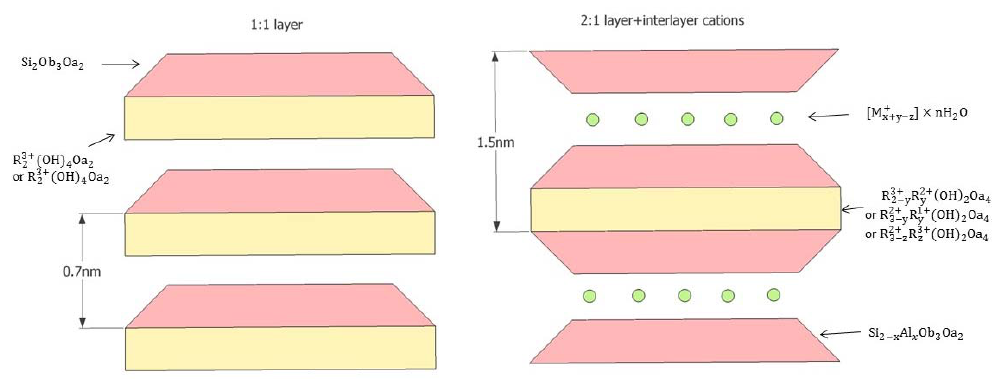
Figure 1. Different layer structures, 1:1 layer (i.e., kaolinite) and 2:1 layer (i.e., smectite) [51].